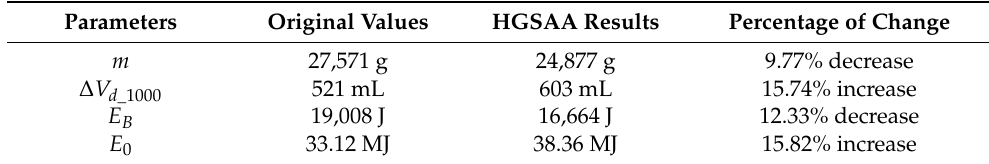
Table 4. The HGSAA optimization results of the performance parameters.